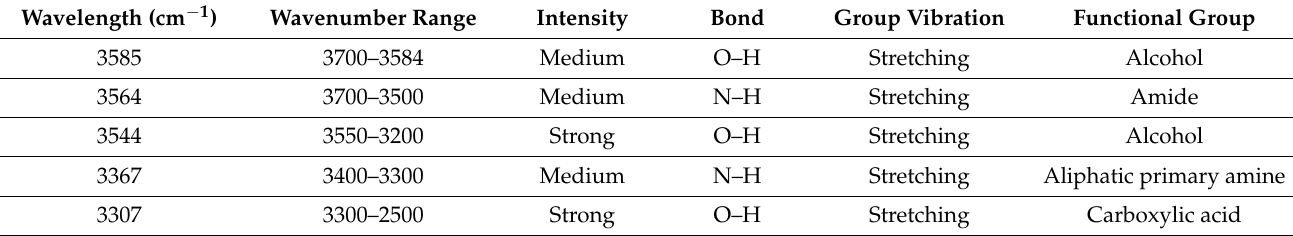
Figure 3. FTIR spectra of Nephelium lappaceum seed . 4000.0